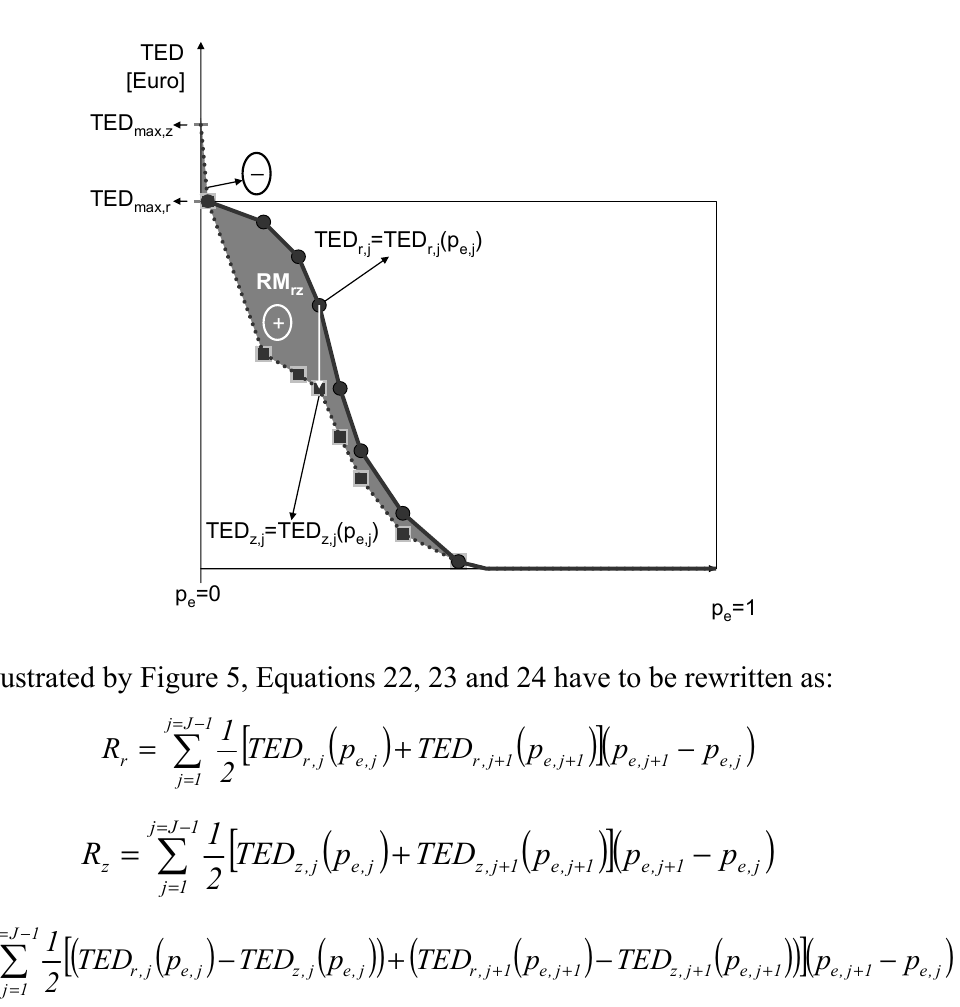
Figure 5. Graphical representation of the risk mitigation performance strategy